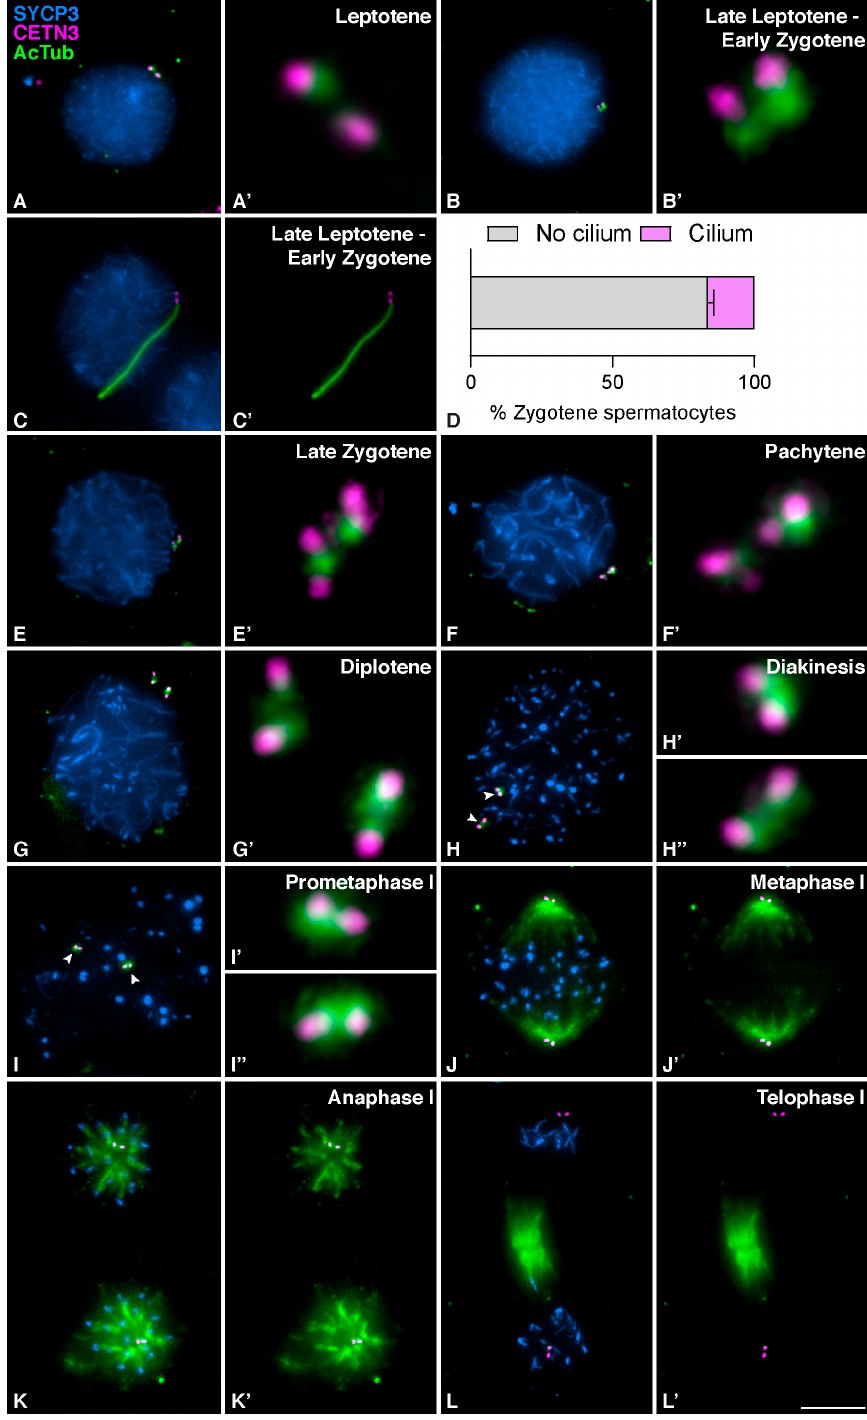
Figure 1. Mouse spermatocytes form transient cilia during meiotic prophase I. Detection of acetylated tubulin in mouse spermatocytes during the first meiotic division. Triple immunolabelling of synaptonemal complex protein 3 (SYCP3) (blue), Centrin 3 (CETN3) (magenta), and acetylated Tubulin (AcTub) (green) on squashed WT mouse spermatocytes at ( A ) Leptotene, ( B ) Leptotene to zygotene transition, Late leptotene-Early Zygotene, without cilium, ( C ) Late Leptotene-Early Zygotene, with cilium, ( D ) Graphical representation of the quantification of ciliated spermatocytes at Zygotene ( n = 100, three biological replicates), ( E ) Late Zygotene, ( F ) Pachytene ( G ), Diplotene, ( H ) Diakinesis, ( I ) Prometaphase I, ( J ) Metaphase I, ( K ) Anaphase I, and ( L ) Telophase I. For images ( A ′ – I ′ ) the 300× magnification for centrosomes is shown (( H ′ , H ″ ) and ( I ′ , I ″ ) white arrowheads). Scale bar in ( L ′ ) represents 5 µm.